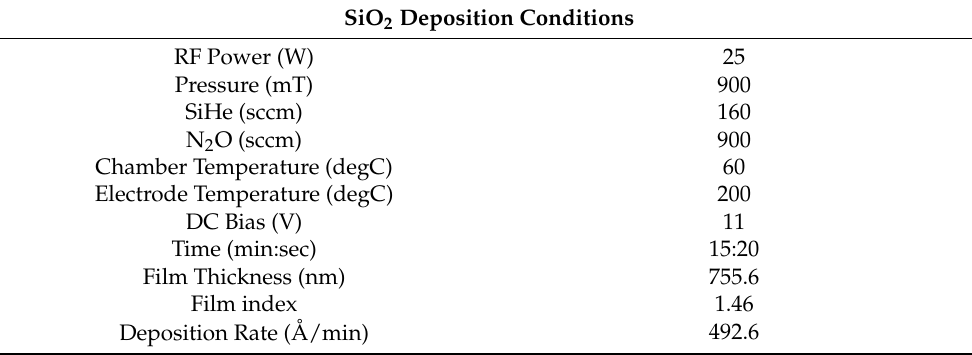
Table A1. Deposition condition for silicon dioxide grown by PECVD for the structural